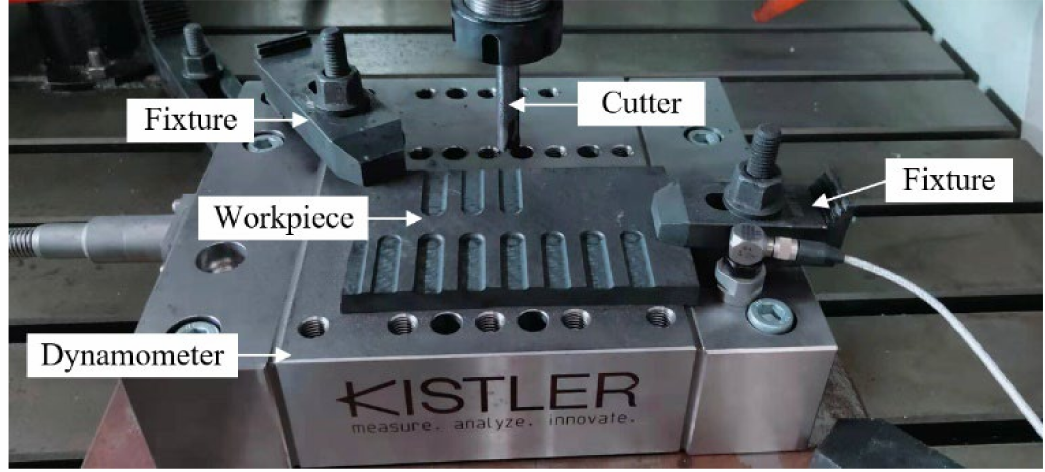
Figure 4. Experimental